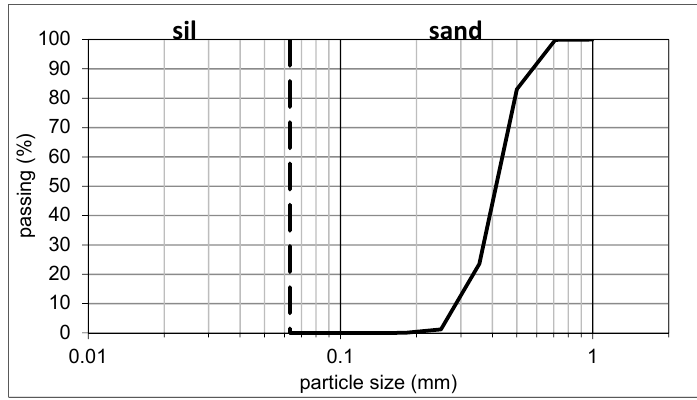
Figure 1. The grain size distribution curve.